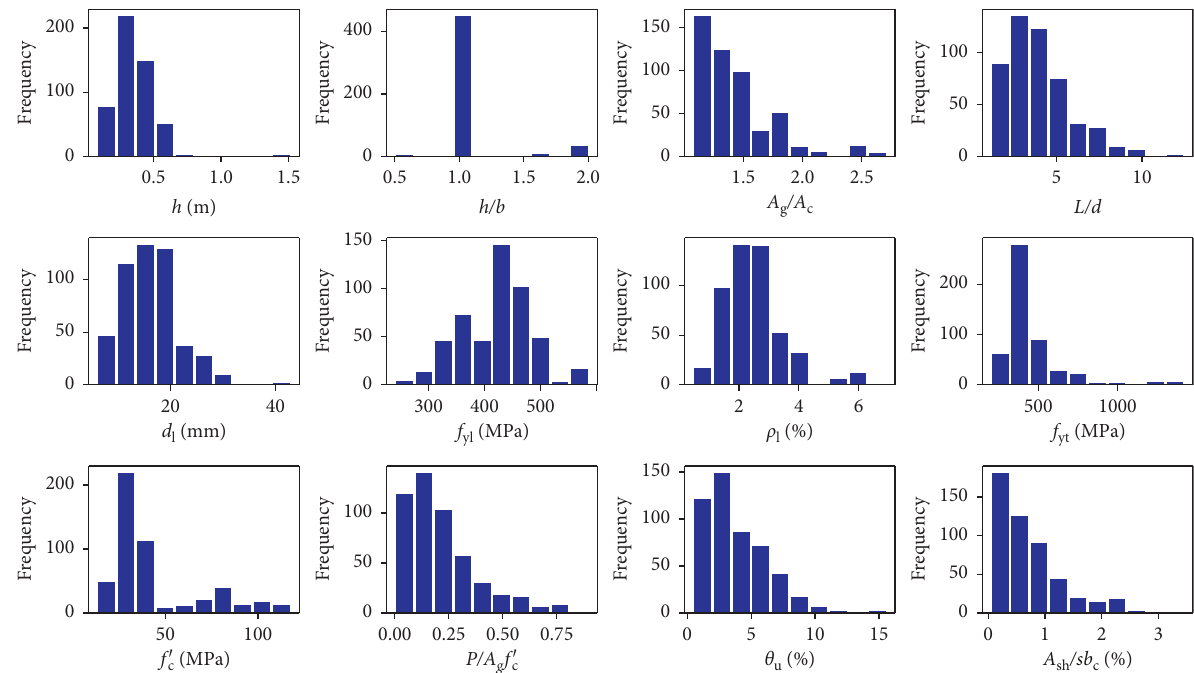
Figure 3: Distribution of input and output variables.